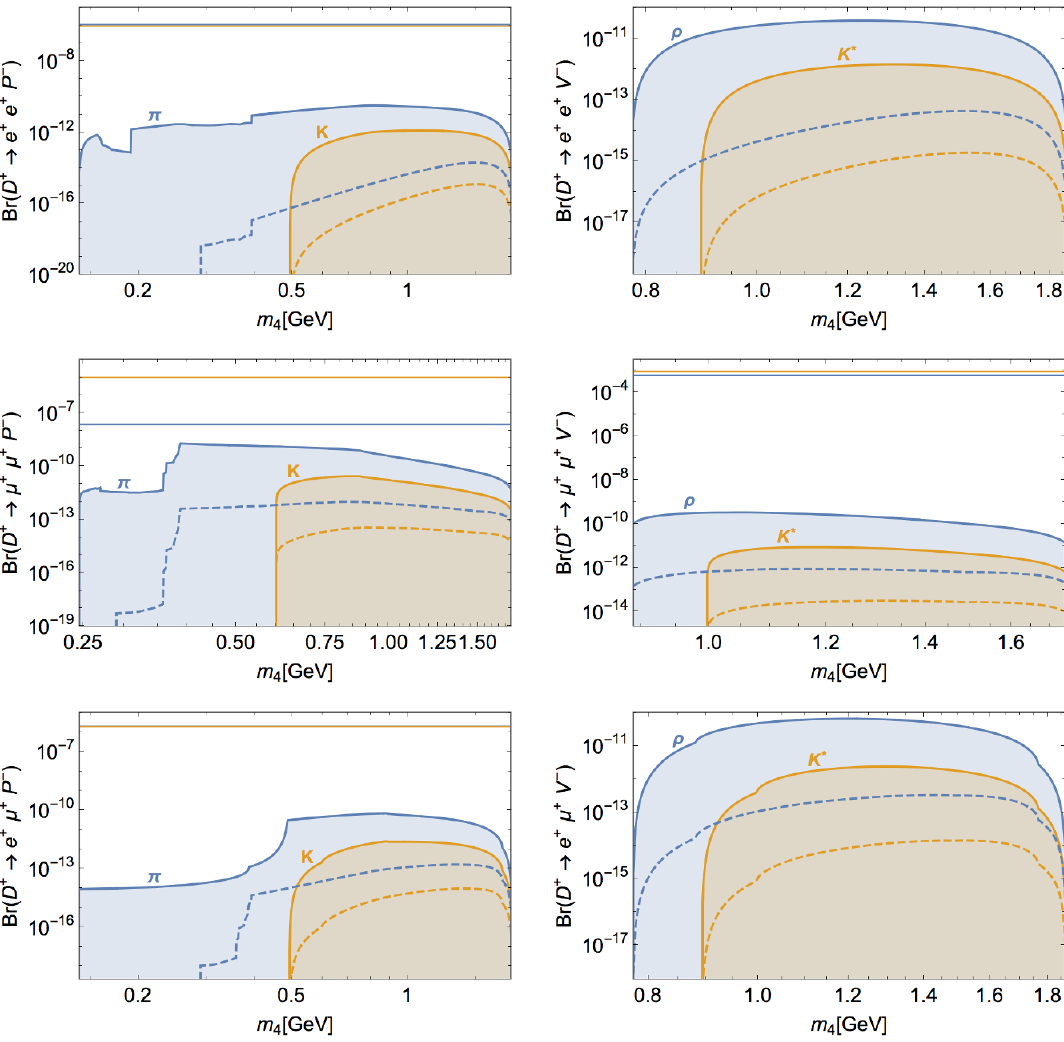
Figure 14 . Branching ratios of LNV decay modes of D mesons into pseudoscalar (left panels) and vector (right panels) (cid:12)nal states, plus leptons of same or di(cid:11)erent (cid:13)avour, as a function of the (mostly sterile) heavy neutrino mass, m 4 . Line and colour code as in (cid:12)gure